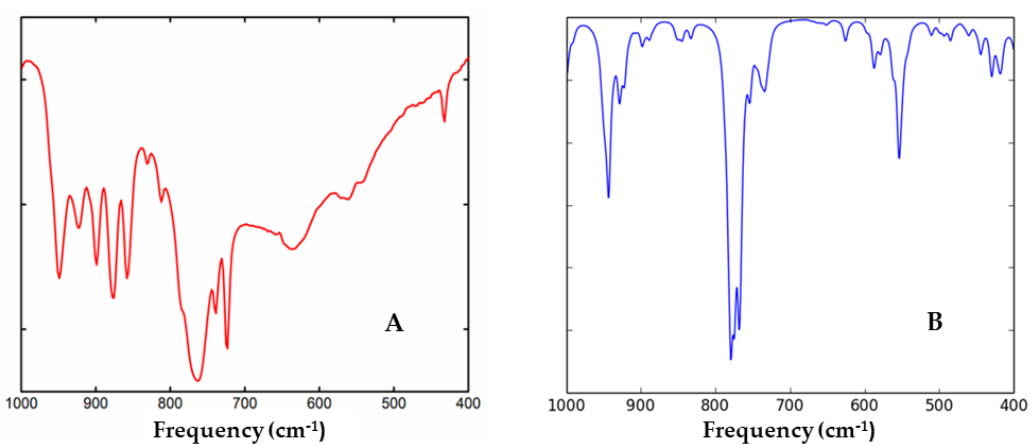
Figure 10. Experimental ( A ) and theoretical ( B ) IR spectrum of Compound 1 calculated at the M06-2X / Def2TZVP-LANL2TZ(f) level of theory using the ECP = LANL2TZ(f) for V and Cu in the CPCM model and water solvent.